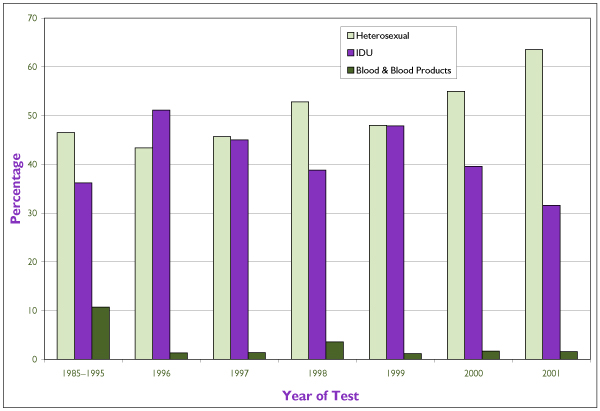
Distribution of Exposure Category among Adult (≥ 15 Years) Female Positive HIV Test Reports, by Year of Test, Canada (1985/95–2001) Source: Data from HIV and AIDS in Canada, Surveillance Report to December 31, 2001